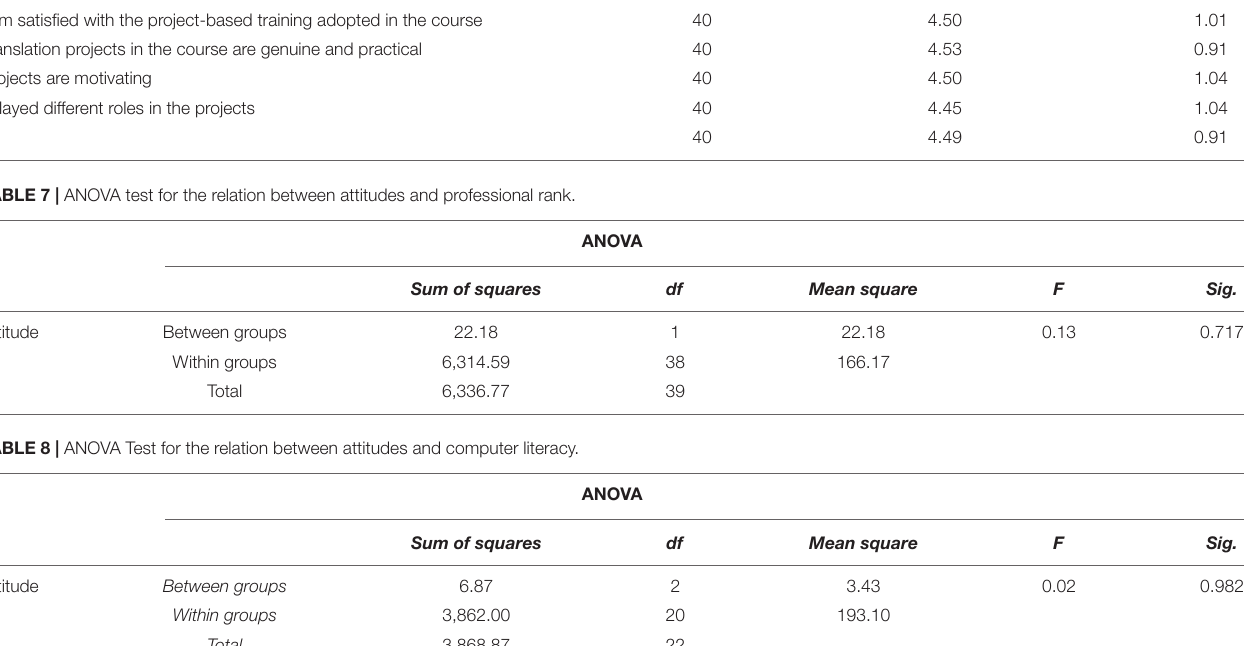
TABLE 6 | Trainees’ attitudes toward the training approach. Items